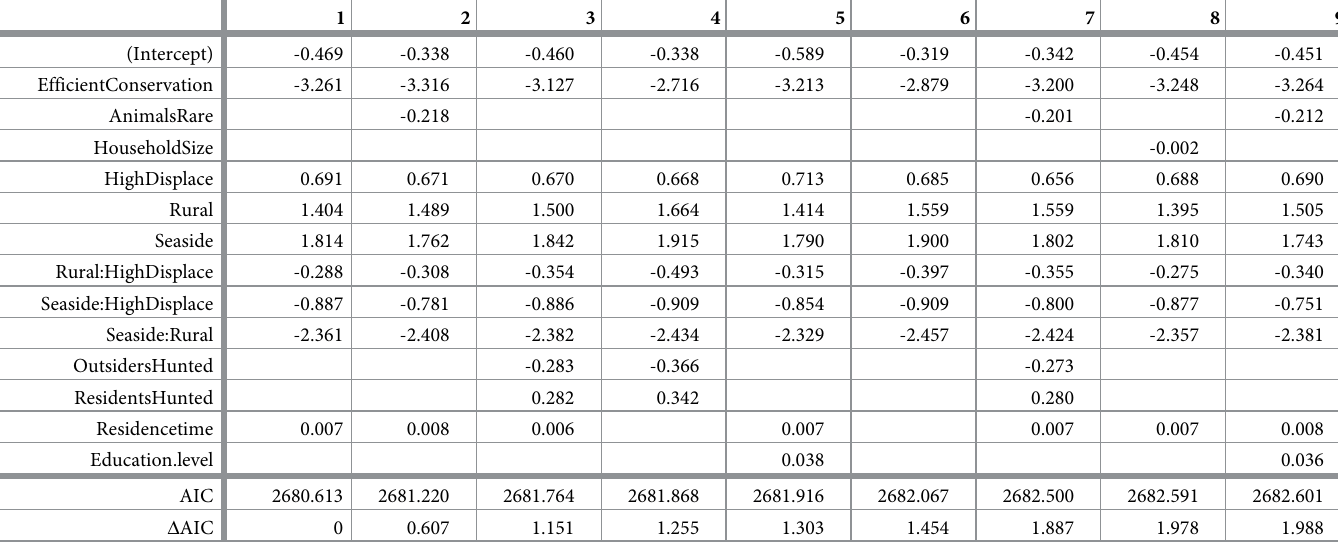
Table 4. Top models with Δ AIC less than 2 for Efficient Conservation + (alternative livelihoods) 2 . Δ AIC, maximum likelihood estimates for models fitted to random- ized responses. All model fits are based on the EM algorithm with 20 different random starting values to avoid convergence to local modes.